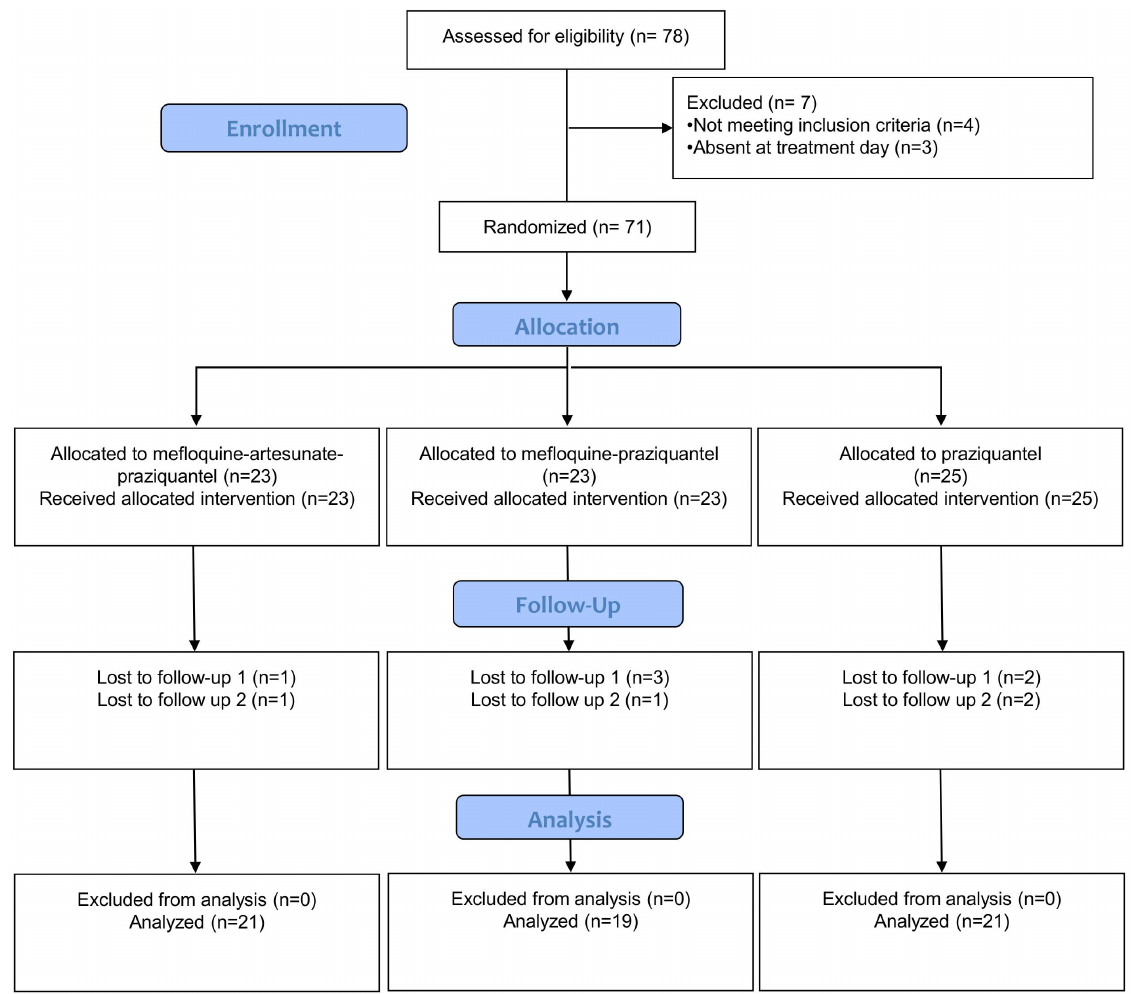
Figure 1. Consort flowchart. Study enrollment, allocation, follow-up, and analysis.